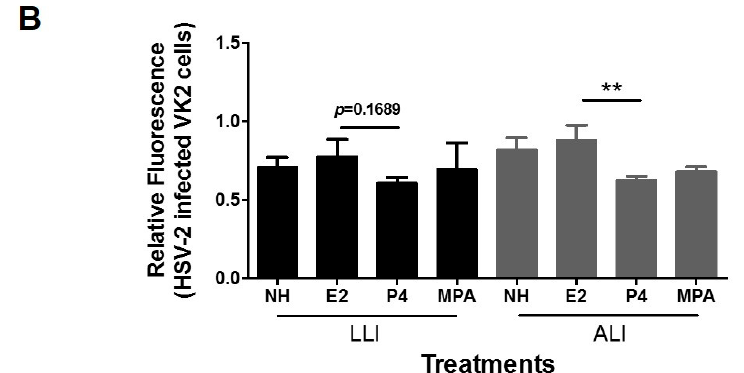
Figure 4. Effect of female sex hormones and MPA on HSV-2-GFP infection in Vk2 cells grown in ALI and LLI. Vk2 cells grown for 10 days to confluence in the presence or absence of female sex hormones were exposed to HSV-2-GFP at 10 4 plaque-forming units (PFU) for two hours in both ALI and LLI. Nuclei were counter-stained with propidium iodide. ( A ) Images were taken to compare green fluorescence visually; ( B ) Relative fluorescence of HSV-2/GFP (green) to nuclear stain (red) was measured to quantify the amount of HSV-2 infection per cell. Data shown represented mean ± SEM of three separate cultures. ** p < 0.01. All samples were imaged on an EVOS™ FL digital inverted fluorescence microscope with a 20 × objective. Images presented are representative of one of three images acquired from the experiments.